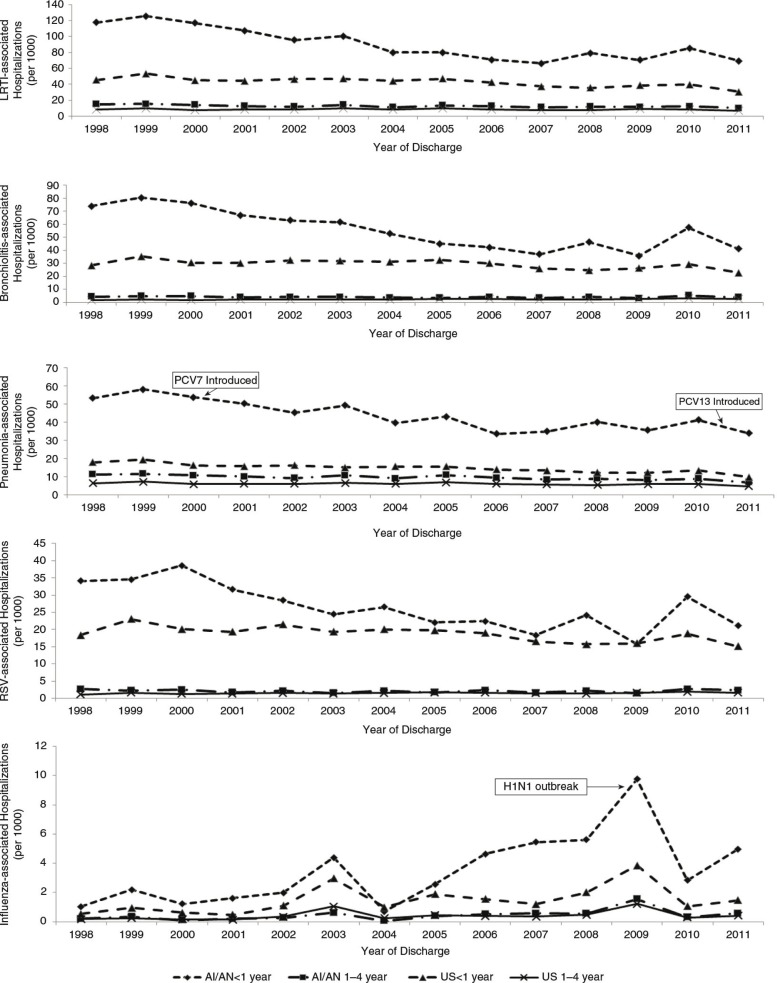
Annual hospitalization rates associated with lower respiratory tract infection (LRTI), bronchiolitis, pneumonia, respiratory syncytial virus (RSV) and influenza among American Indian and Alaska Native (AI/AN) children and among the general US child population <5 years by age group, 1998–2011. Data from IHS National Patient Information Reporting System (7) for AI/AN children and the Nationwide Inpatient Sample for the general US child population (8).